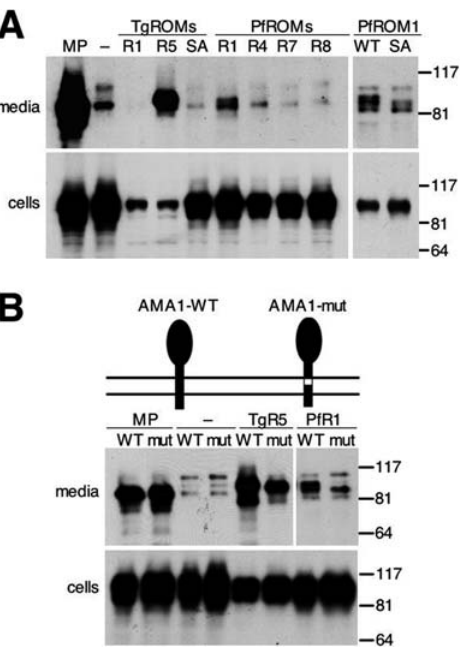
Figure 3. Cleavage of PfAMA1 by Parasite Rhomboid Enzymes (A) GFP-tagged AMA1 was transiently co-transfected with various rhomboid genes into COS cells. Both TgROM5 and PfROM1 cleaved AMA1, as evidenced by detection of the cleaved form in media by anti- GFP Western analysis, but failed to do so when their active site serines were mutated to alanine (SA). BB1101 was used to inhibit AMA1 shedding by endogenous cellular metalloproteases in all lanes in (A) and (B) except those denoted MP, which served as positive controls. (B) Region of AMA1 important for substrate recognition by rhomboid proteases. Mutation of the top region of the AMA1 transmembrane domain (white region in diagram) ASSAA to VLVVV strongly reduced AMA1 cleavage by TgROM5 and PfROM1, but not by cellular metal- loproteases (MP). Molecular weight standards in kDa are denoted to the right of each panel. DOI: 10.1371/journal.ppat.0020113.g003